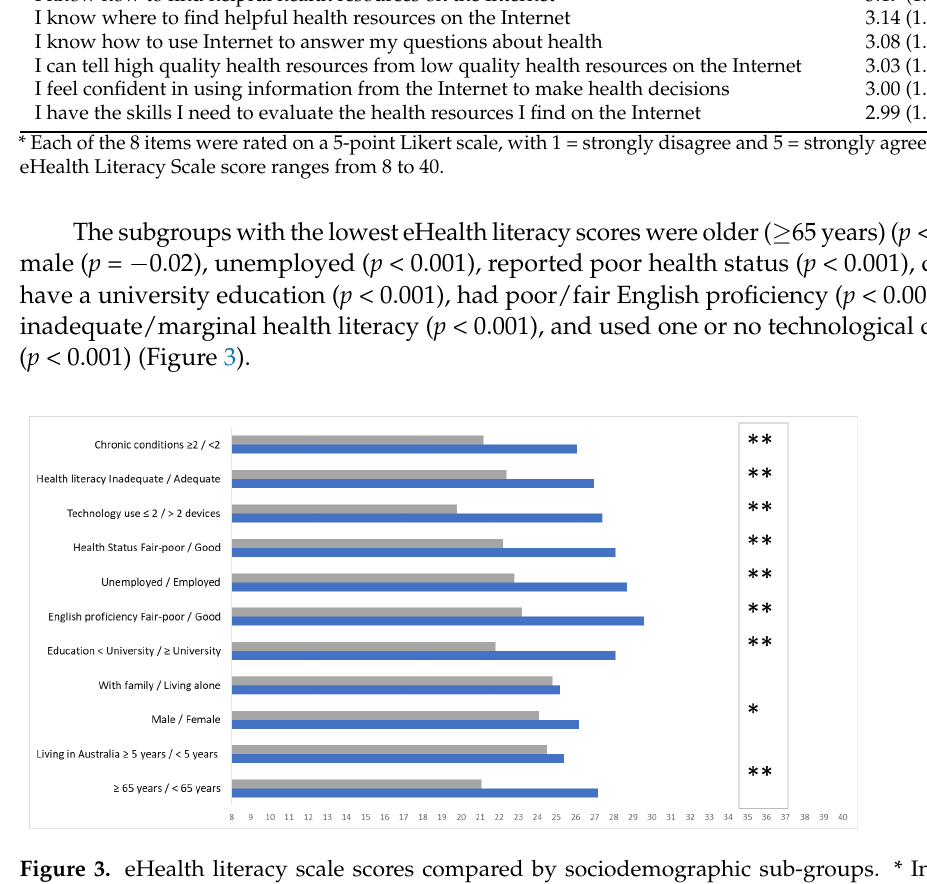
Figure 3. eHealth literacy scale scores compared by sociodemographic sub-groups. * Indicates p < 0.05, ** indicates <0.001.